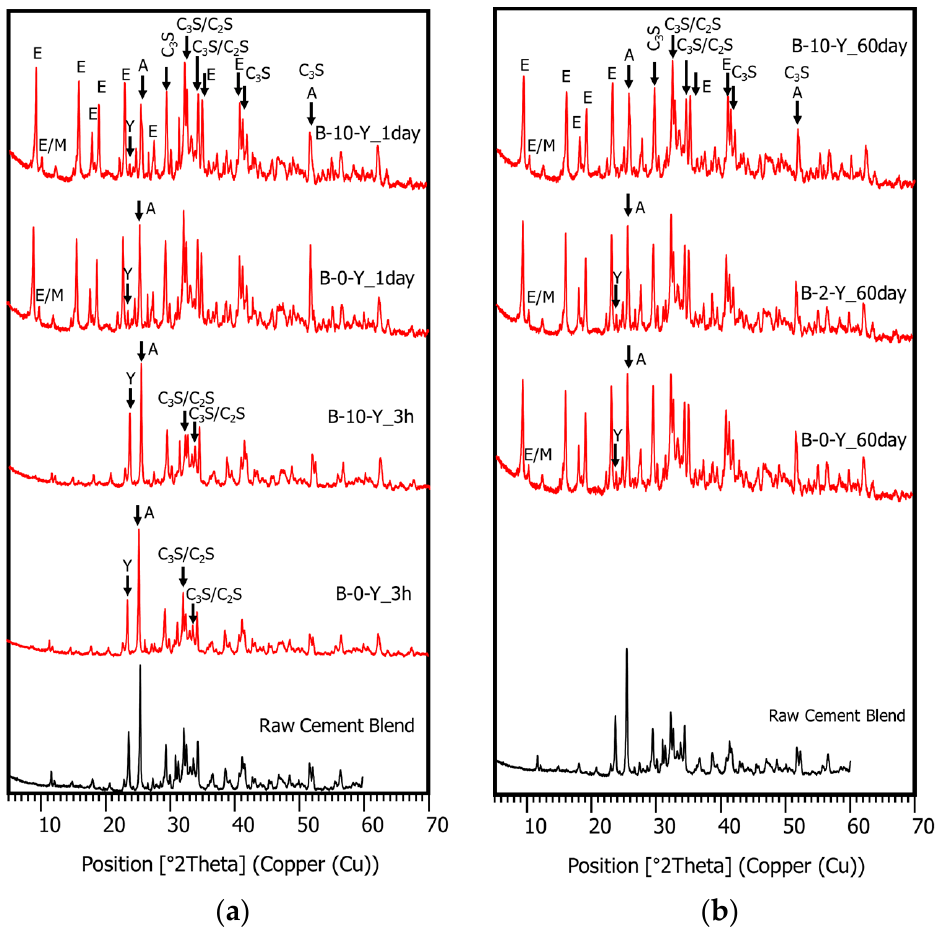
Figure 9. The XRD patterns of the cement blend pastes with varied polymer ratios: ( a ) B-0-Y and B-10-Y at 3 h and 1 day; ( b ) B-0-Y, B-2-Y and B-10-Y at 60 days.